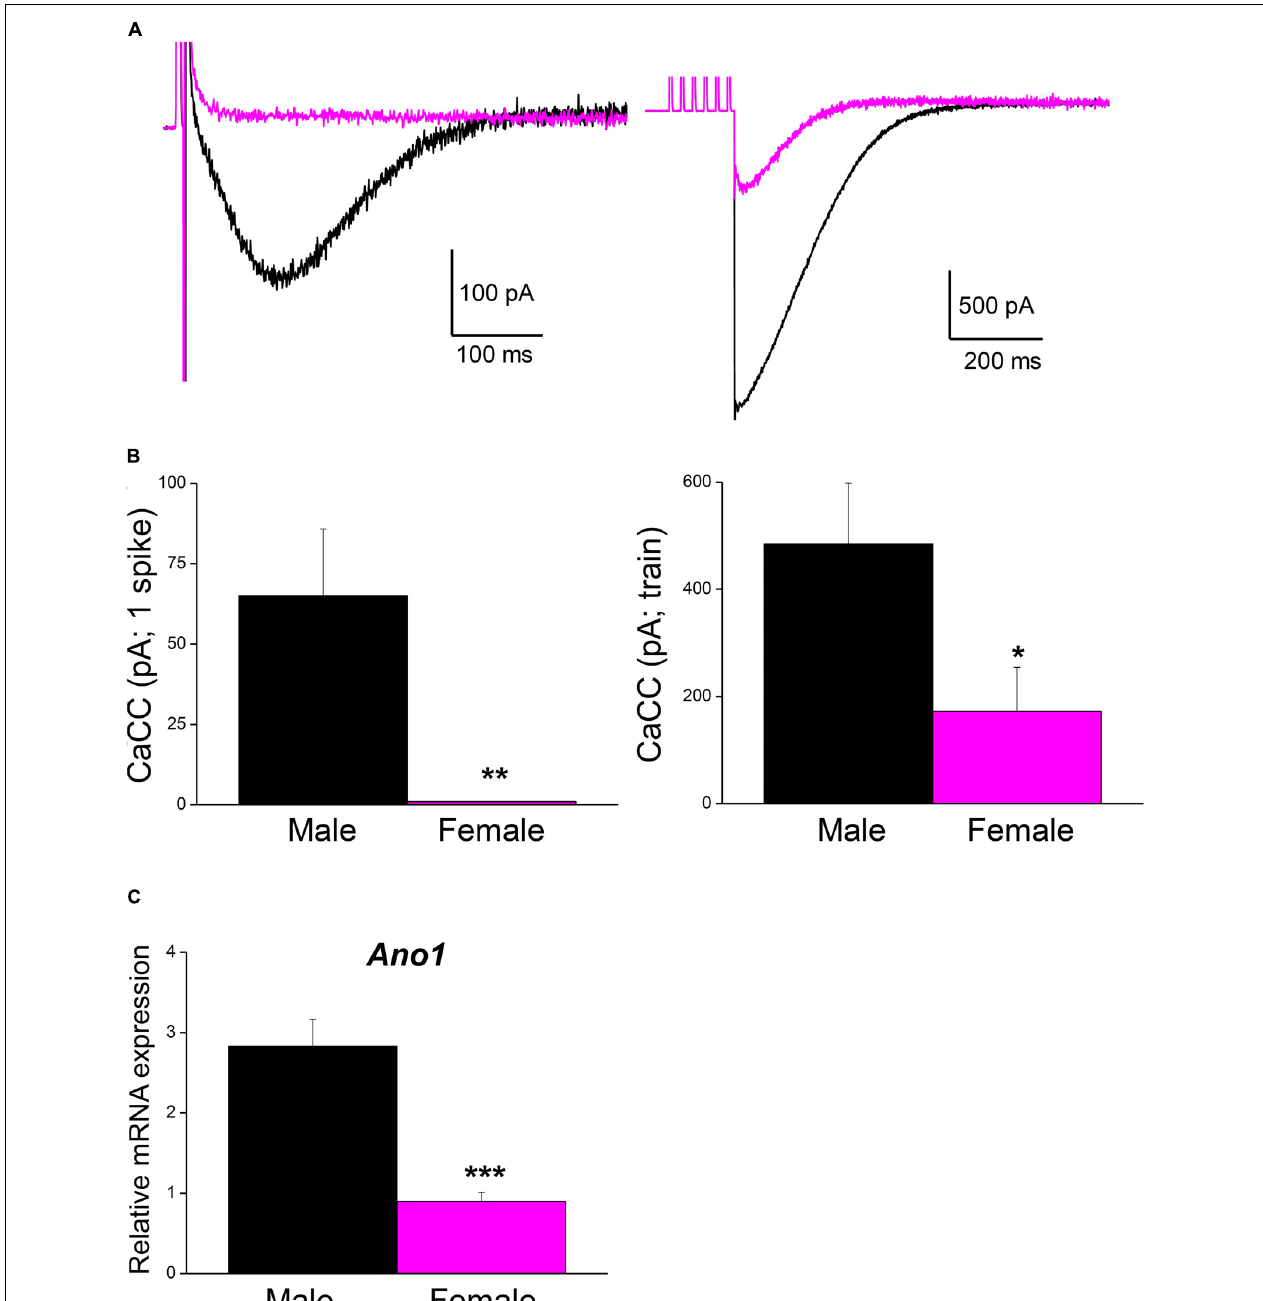
FIGURE 5 | Ca 2 + -activated Cl − current is larger in male than in female mouse SCG neurons. (A) Representative recordings of isolated CaCC after a single AP (left) and after a train of 6 spikes at 40 Hz (right) in an hybrid-clamp protocol in the presence of apamin to block I K ( Ca ) (see section “Material and Methods”). APs were evoked with short (5 ms) intracellular current pulses (0.5–1 nA). Recordings from male (black) and female (magenta) are superimposed. (B) Average values of isolated CaCCs after a single AP (left) and after a train of 6 spikes at 40 Hz (right) in males (8 cells; black) and females (8 cells; magenta). Student’s t -test: ∗ P < 0.05; ∗∗ P < 0.01. (C) SCG mRNA expression levels of Ano1 (male n = 9, female n = 8), normalized to that of Hprt . Mann–Whitney test, ∗∗∗ P <